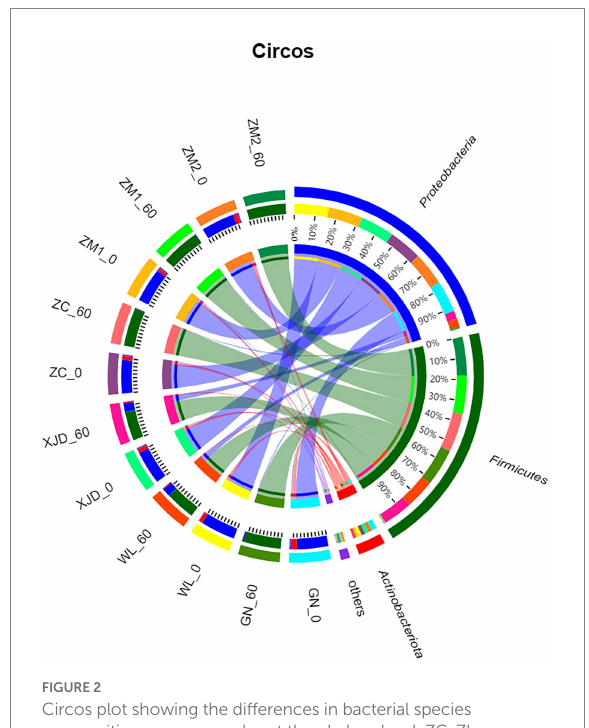
FIGURE 2 Circos plot showing the differences in bacterial species composition across samples at the phylum level. ZC, Zhongcao No. 3; ZM1, Zhongmu No. 1; ZM2, Zhongmu No. 2; GN, Gongnong No. 1; WL, WL168; XJD, xinjiangdaye; 0, 0 day of ensiling; 60, 60 days of ensiling.